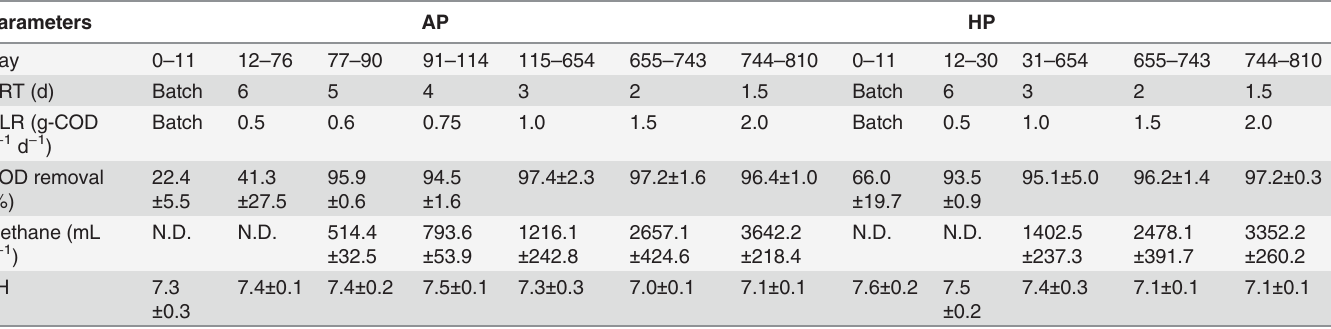
Table 1. Operational parameter of anaerobic packed-bed (AP) and hybrid packed-bed (HP) reactors.